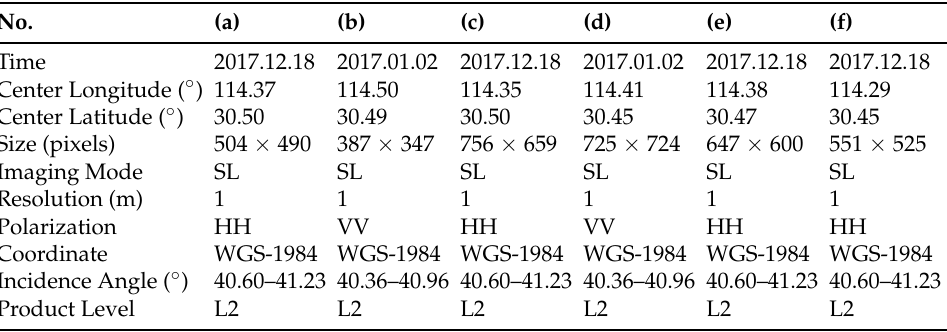
Table 2. The information of GF-3 images.